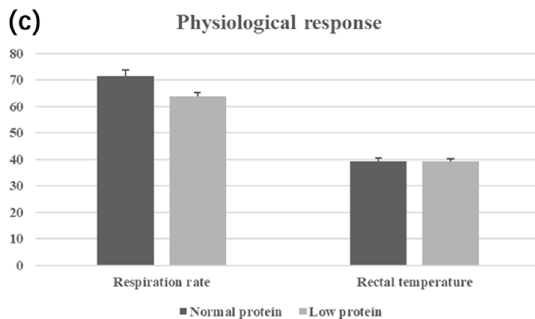
Figure 1. Environmental parameters and physiological response of finishing pigs during trial period. ( a ) Average full-day trial period barn temperature; ( b ) average full-day trial period barn hu- midex; ( c ) respiration rate (breaths/min) and rectal temperature (°C).